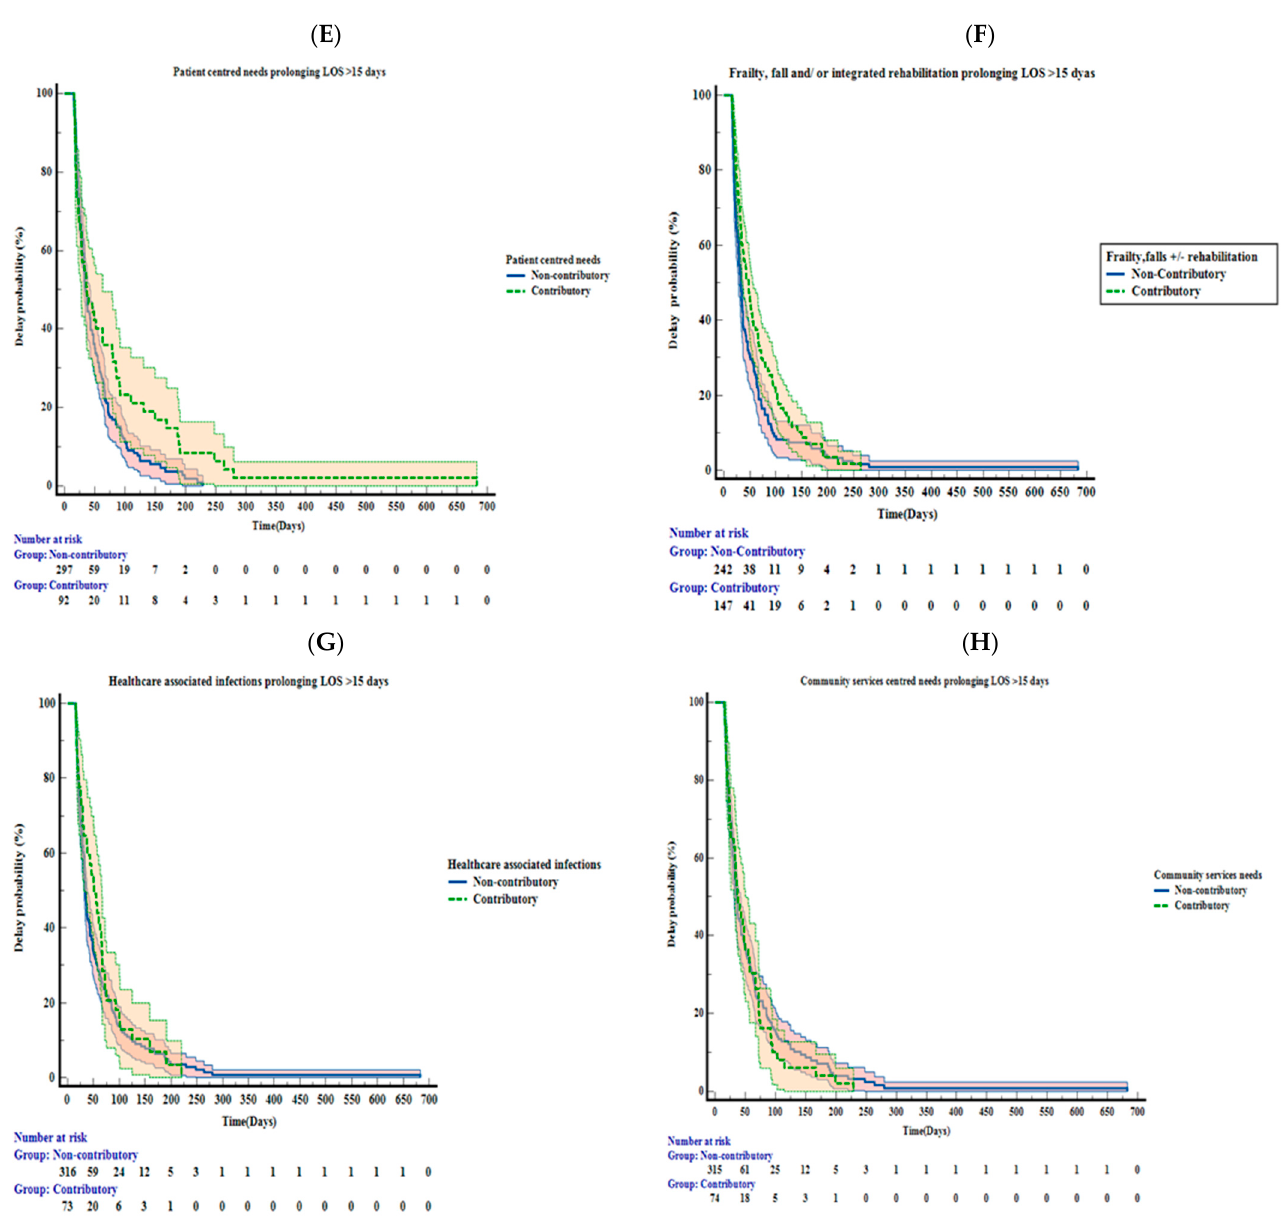
Figure 1. Kaplan–Meier curves for ( A ) age, ( B ) gender, ( C ) multimorbidity, ( D ) complications arising from primary diagnoses, ( E ) healthcare-associated infections, ( F ) frailty or falls